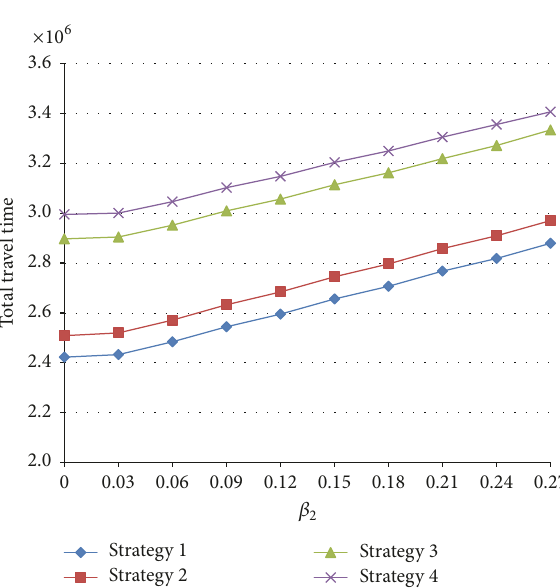
Figure 10: Relation between 𝛽 2 and total travel